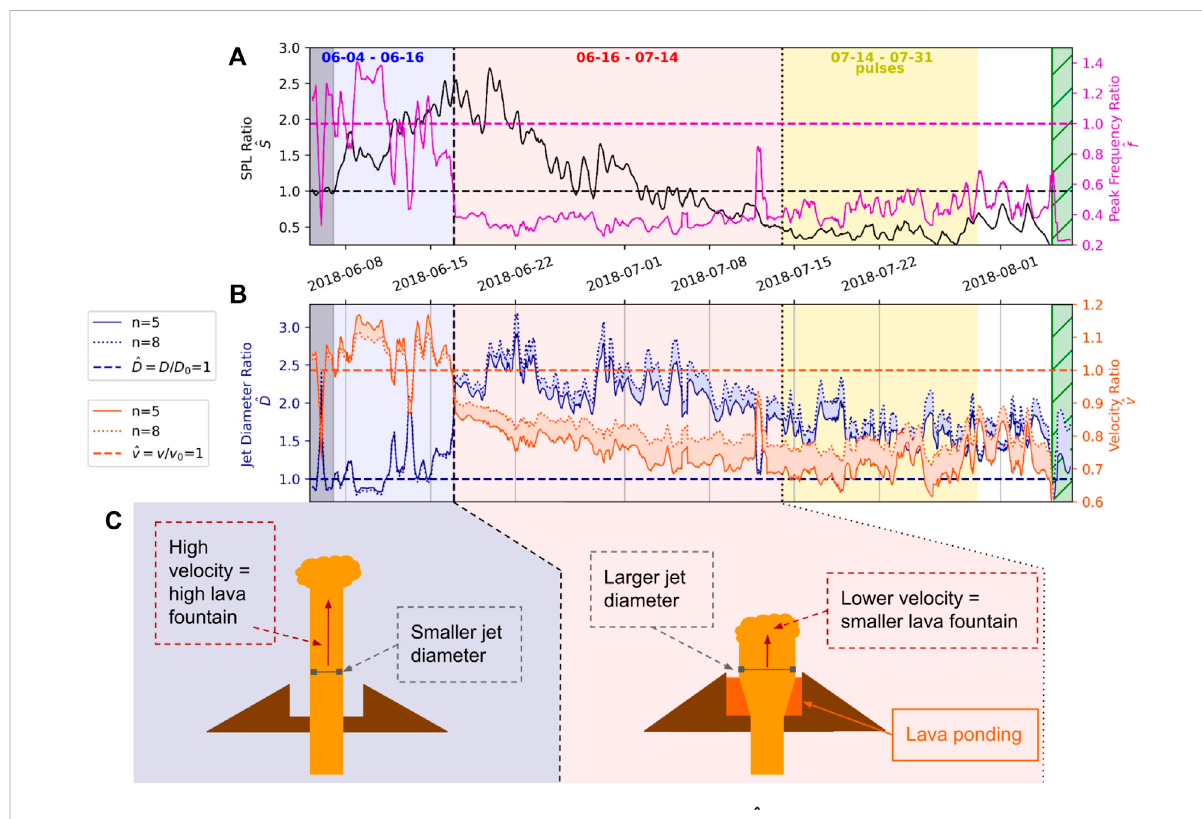
FIGURE 8 Jetnoise scaling model results. (A) Shows theSPL ratio ^ S as ablackline with amplitudes on thelefty-axis and peakfrequencyratio ^ f inmagenta withamplitudevaluesontherighty-axis. (B) Showsthemodelresults.Thedarkgreypanelinthebeginningofthetimeseriesshowsthetimewindow used to calculate the initial parameters SPL 0 and f 0 used to calculate the input parameter ratios. The dark blue lines show the change of jet diameter ratiowithtimewiththesolidlineshowingtheminimumvelocityexponentof n =5andthedottedlinethemaximumassumedvelocityexponent of n = 8. Values for the diameter ratio are shown on the left y-axis and D / D 0 = 1 is marked with a horizontal dashed blue line. The orange lines show thechangeofvelocityratiowith valueson therighty-axis andlinestyleslikethediameter ratiowhich arealso labeledinthelegend. The background colors and vertical dashed and dotted lines are the same as in Figure 1. (C) shows a sketch illustrating the interpretation of the modelling results with backgroundcolors indicating the time window thesketch is corresponding to. On the left, the initial high velocity and low jet diameter is interpreted asatallnarrow fountain. Ontherightthedecreaseinvelocityandincreaseinjetdiameter isinterpretedasadecreaseinfountainheightandincrease in fountain diameter, potentially due to the evolving